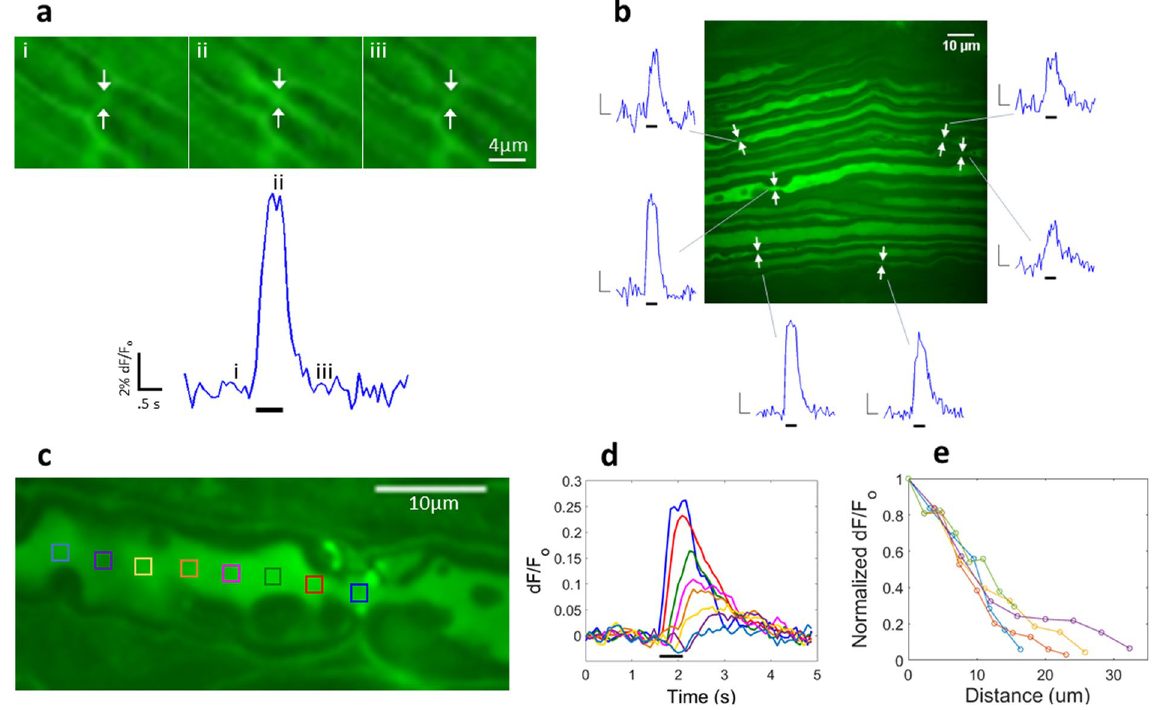
Figure 1. Single sweep action potential elicited calcium-responses at nodes of Ranvier ( a ) Response signal to 50 action potentials (100 Hz). Top panel images show an individual node of Ranvier before the action potential stimulus ( i ), during ( ii ), and after ( iii ) (arrows indicate the node location). Bottom panel is the quantitative optical signal produced by nodal image pixels (ROI is approximately 3 × 2 µ m). Thick black bar indicates action potential stimulus. ( b ) Field of tibial nerve axons with at least six nodes of Ranvier yielding a calcium- coupled fluorescence change in response to a 1 s train of action potentials (100 Hz). Signal amplitudes among the six nodes range from 11–24%. Inset scale bars: 1 s and 5 % signal change . ( c ) Longitudinal calcium signal propagation in an axon segment with node of Ranvier) ( d ) Activity dependent calcium fluorescence in response to a 50 action potential burst (100 Hz) recorded at incremental distances away from the node epicenter (signal trace colors correspond to ROIs in panel c). Plotted signals illustrate the latency in signal onset as well as reduced signal amplitude with distance from the node. ( e ) Peak normalized signal amplitude versus distance from node from five axon nodes. Yellow trace corresponds to the nodal data of panels c and